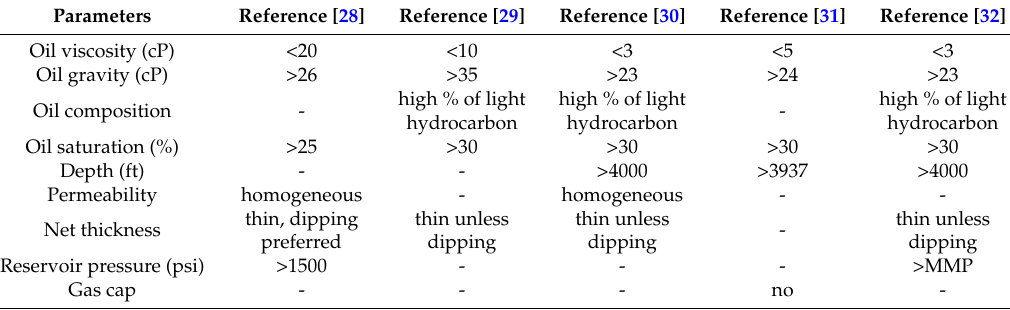
Table 2. Previously-suggested screening criteria for HC gas miscible